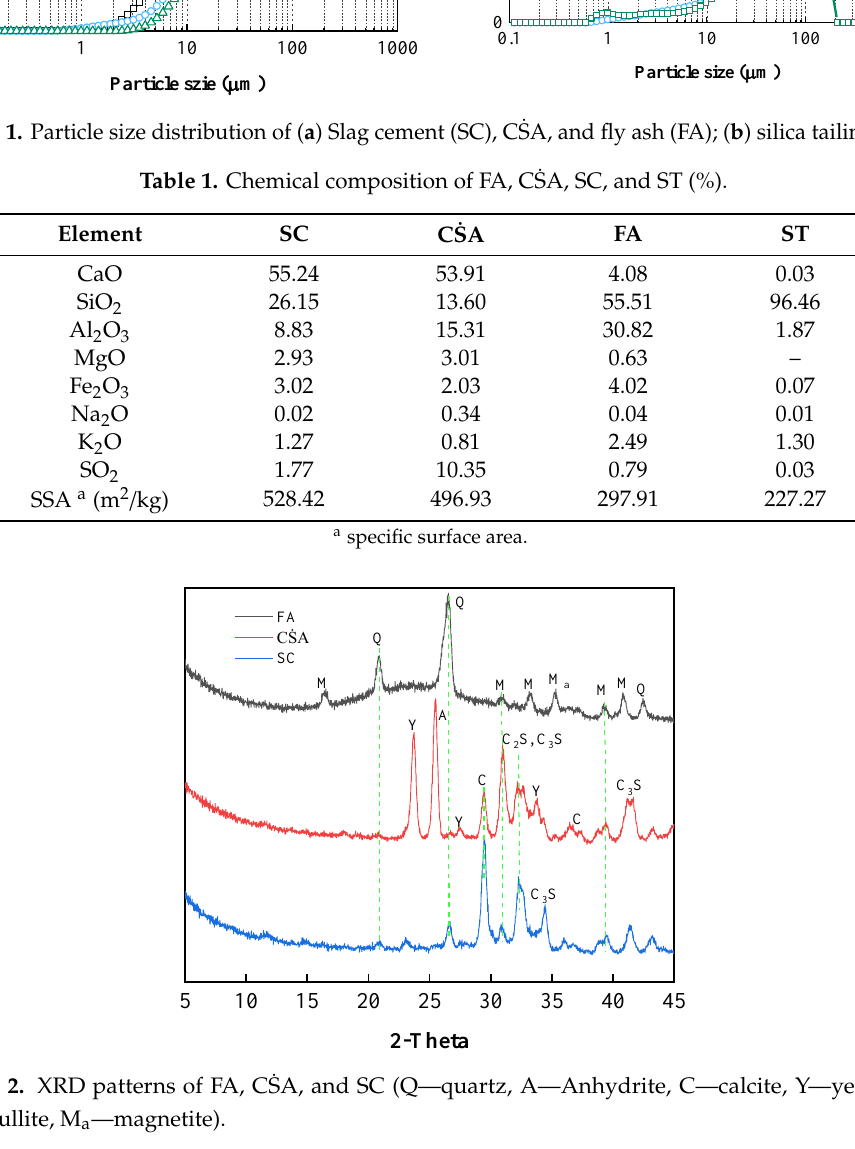
Figure 3. SEM images of ( a ) SC, ( b ) C Ṡ A, ( c ) quicklime, and ( d ) FA (Mag = 3000×). 2.2. Sample Preparation Six groups of pure blended binders were prepared according to the detailed mixing ratios shown in Table 2. The first sample series was prepared to explore the influence of C Ṡ A on hydration reactions. The mass ratios of SC:C Ṡ A:FA:quicklime were 10:0:8:2, 9:1:8:2, and 7:3:8:2, and the sample numbers were defined as SCA0, SCA5, and SCA15, respectively. A second sample series was prepared to confirm the effect of quicklime on the hydration reaction. The mass ratios of SC:C Ṡ A:FA:quicklime were 9:2:8:1, 8:2:8:2, and 7:2:8:3, and the sample numbers were defined as SCC5, SCC10, and SCC15. A control sample was also prepared and named SC100 for comparison. The water/binder ratio was 0.43. Accordingly, seven groups of CPB samples were prepared using blended binders. The binder/ST ratio was 0.2, and the solid concentration was 70% by mass. After mixing for 5 min, a portion of the fresh backfill was subjected to the fluidity test, and the remaining was poured into plastic cylinder molds (5 cm in diameter × 10 cm in height). It should be noted that both of the upper and lower ends of the molds are sealed. All samples were cured at room temperature (20 ± 2 °C) with a relative humidity of 95 ± 2%.